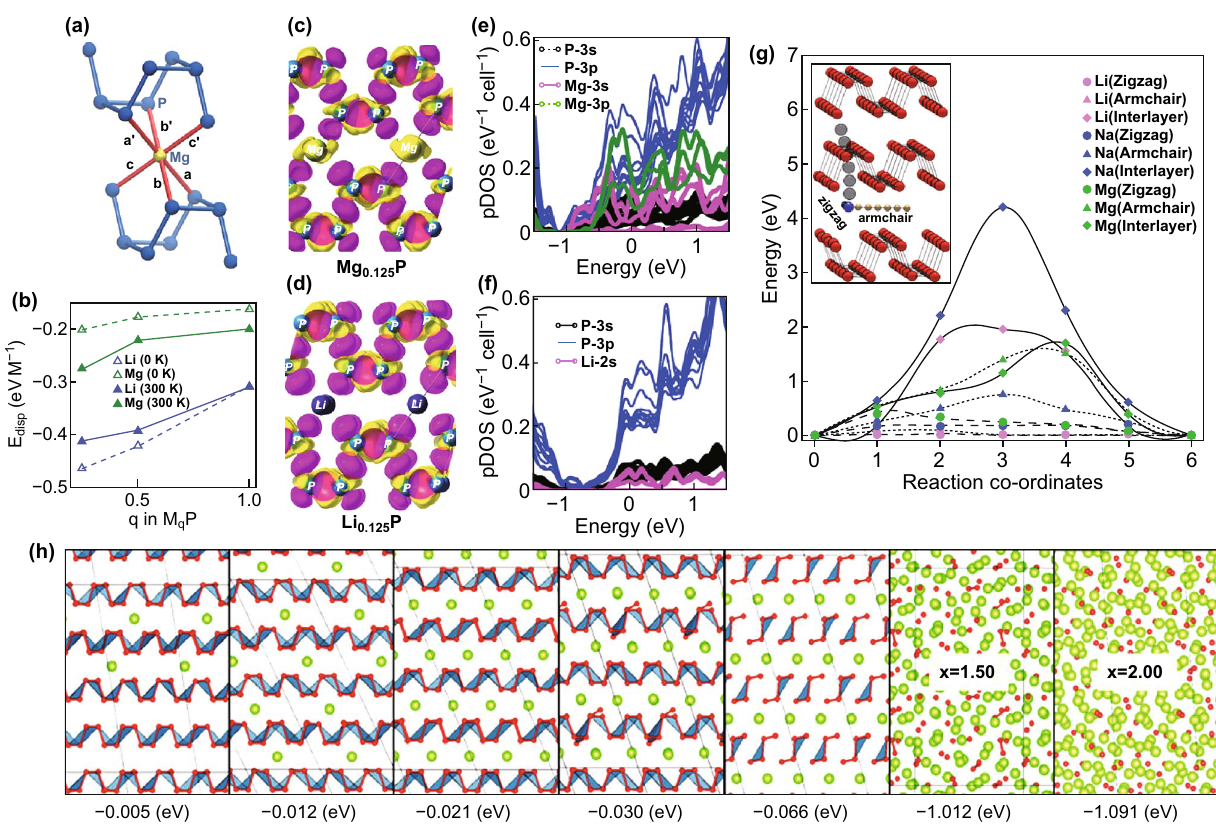
Fig. 12 a Octahedral C.N. of Mg-ions at the a-phase, b the dispersive interaction per M-ions at a (M0.125P), b (M0.50P), and g (MP) phases. Differential charge density for M0.125P (M = Li/Mg), while intercalated M is at the transition state during diffusion along the x-channel (side view): c M = Li and d M = Mg. The loss of electrons is indicated in yellow and the gain of electrons is indicated in pink. The projected density of states (pDOS) of M0.125P (TR): e for M = Li and f for M = Mg. Adapted with permission [210]. Copyright 2016 Royal Society of Chemis- try. g Diffusion barriers of Li, Na and Mg in black phosphorus along three different diffusion paths. Color codes are pink = Li, blue = Na, and green = Mg. h Insertion mechanism in black phosphorus with an increase in concentration of Mg. The solid gray line represents a supercell con- taining 64 P atoms, and the number represents the formation energy. Adapted with permission [211]. Copyright 2016 Royal Society of Chemis- try. (Color figure